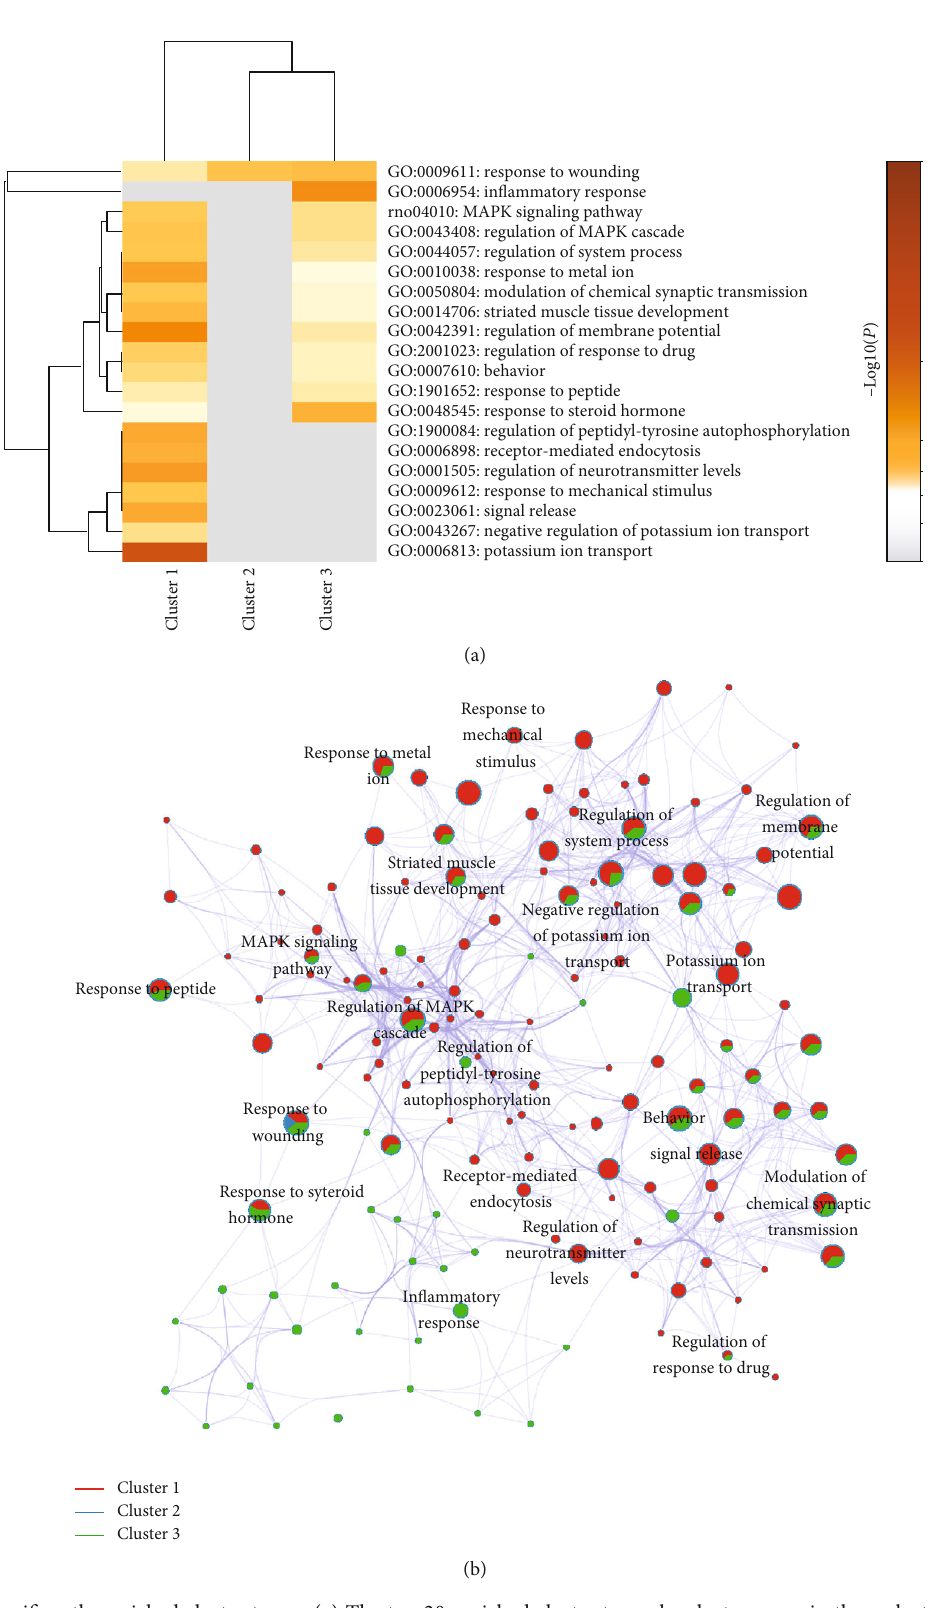
Figure 2: The signi fi cantly enriched cluster terms. (a) The top 20 enriched cluster terms by cluster genes in three clusters. The darker the color, the smaller the p value. (b) The term interaction network constructed by important terms in clusters. The color of di ff erent nodes represents di ff erent clusters, and the connection line represents the genetic similarity between